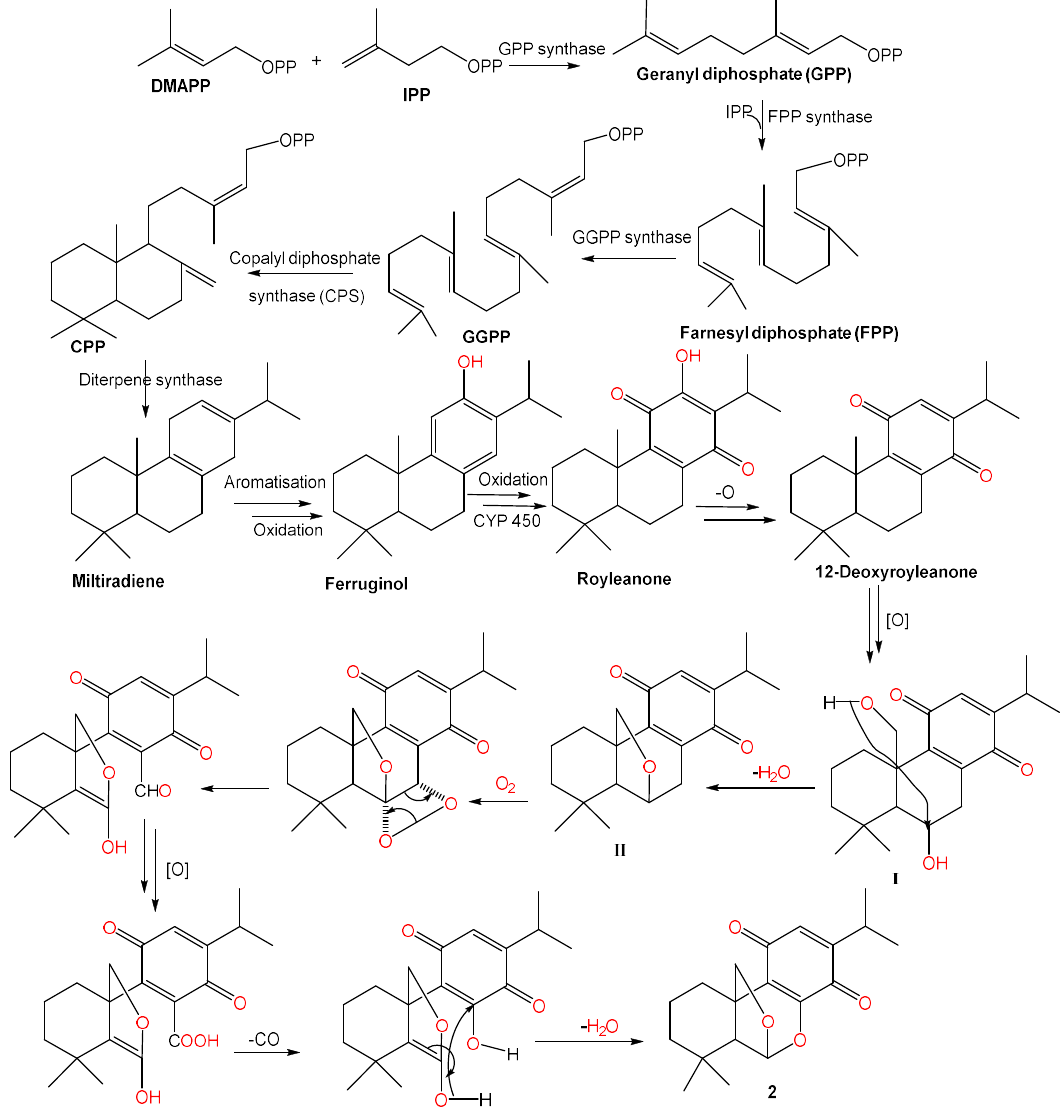
Figure 4. Biogenetic pathway proposed for plectrabarbene ( 2 ).